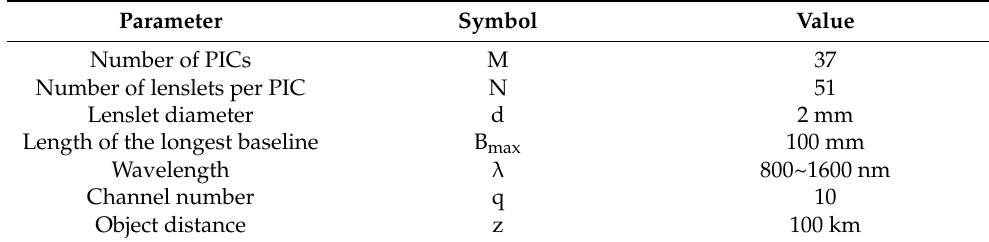
Table 1. System parameters used for simulations.